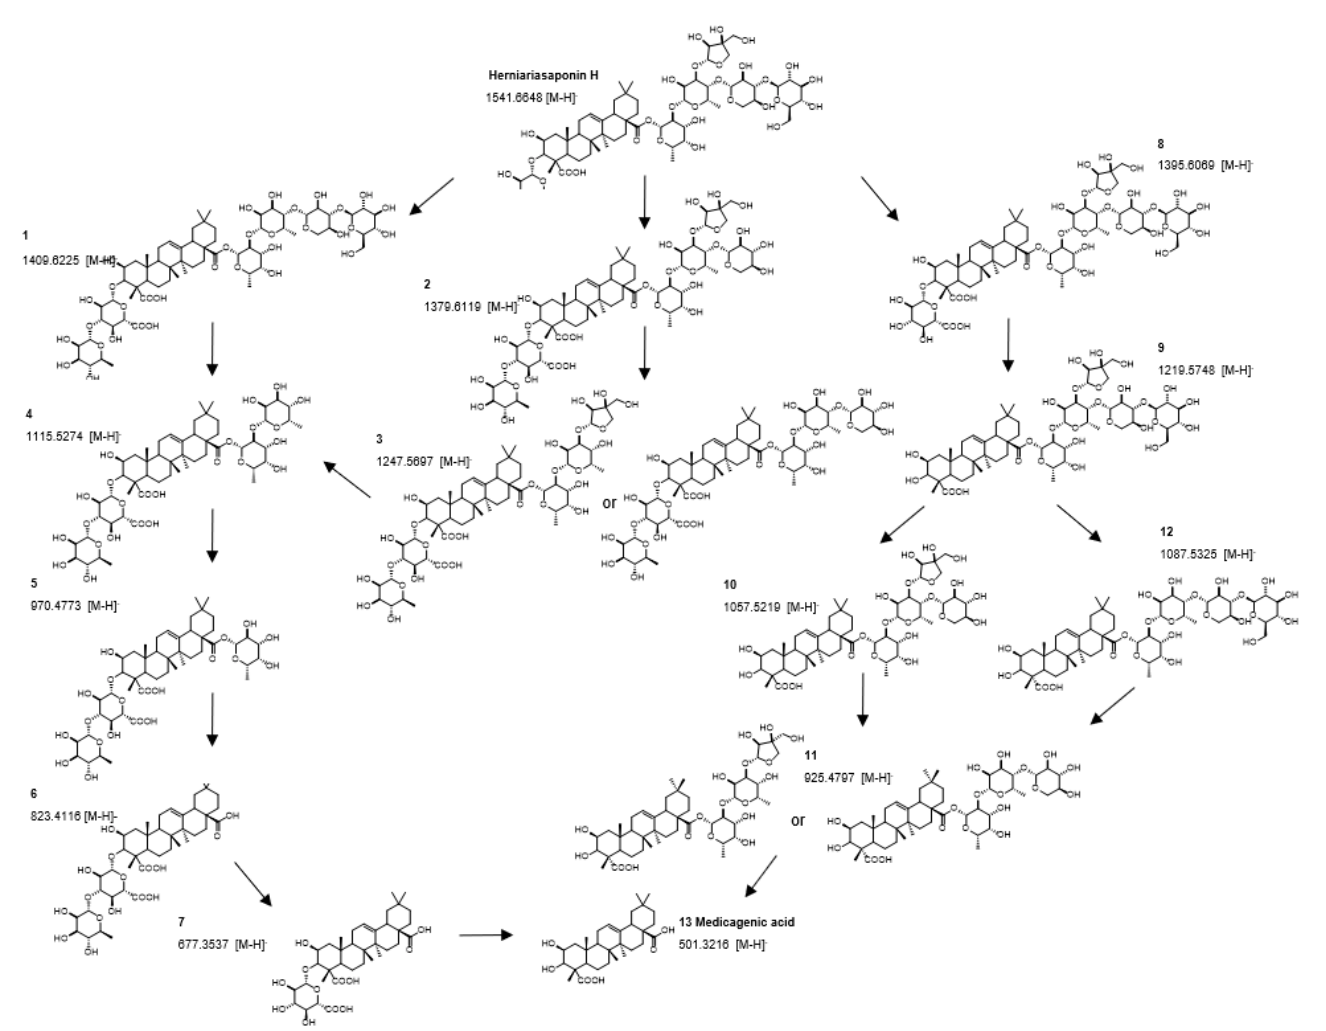
Figure 7. Metabolic pathway of herniariasaponin H by in vitro gastrointestinal